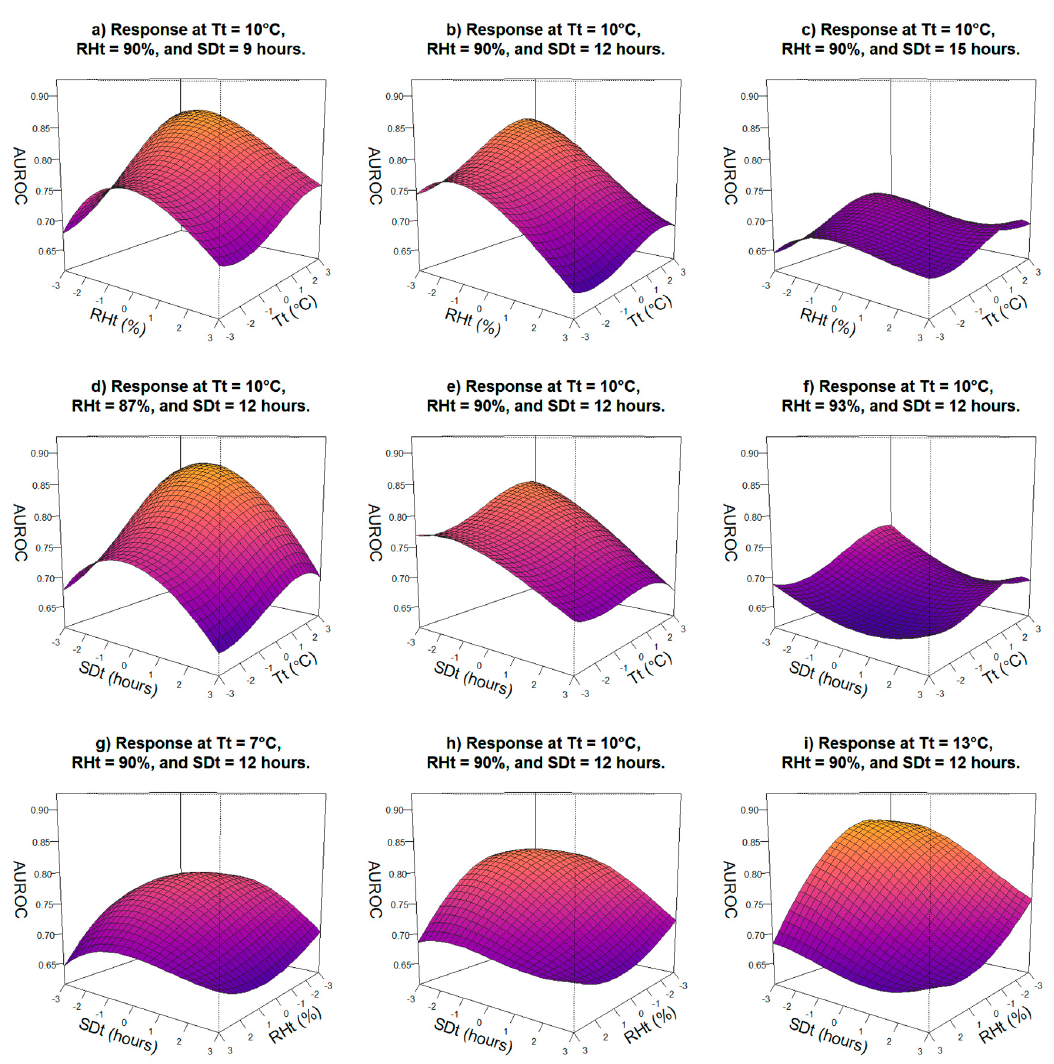
Figure 5. 3D surface for interaction effect of two variables with third variable fixed on a specific level. 3D surface plots represent interaction between: Tt and RHt, with SDt of 7 ( a ), 10 ( b ) and 13 hours( c ); SDt and Tt, with RHt fixed at 87% ( d ), 90% ( e ), and 93% ( f ); and SDt with RHt, with Tt of 7 °C ( g ), 10 °C ( h ), and 13 °C ( i ).